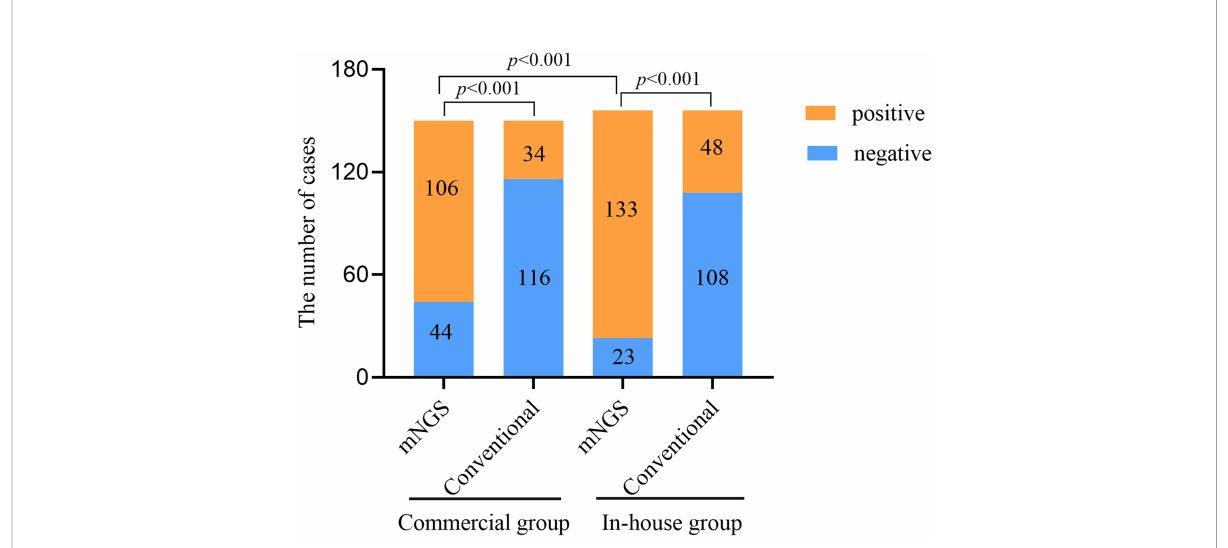
FIGURE 1 Comparison of the positivity rates between metagenomic next-generation sequencing (mNGS) and conventional